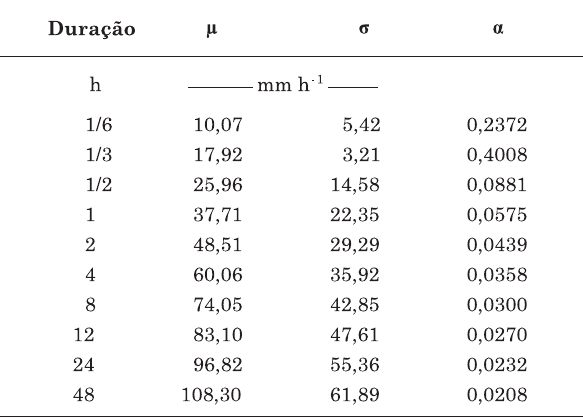
figura 2. Com o uso dessa figura, é possível estimar diretamente a intensidade, a duração e o período